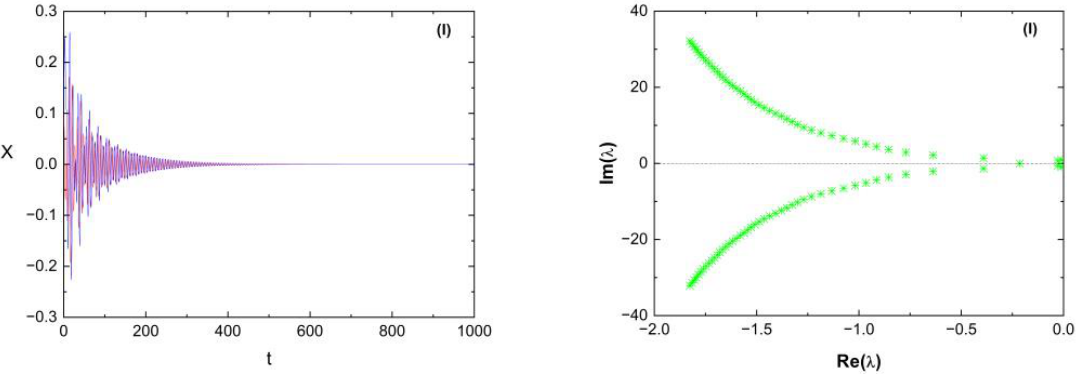
Figure 4. Time − response trajectories of X and Y versus t and the eigenvalues of characteristic equation for networks (17) with ( 1.0,4.3 ) ∈ case ( I ) corresponding to the stable zero solution.